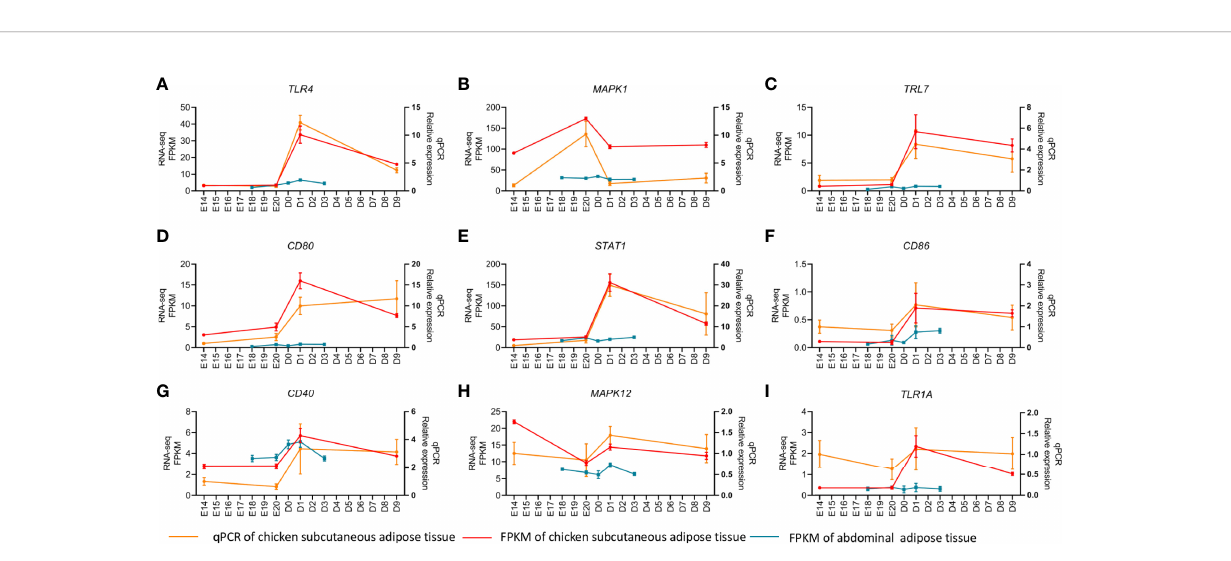
FIGURE 8 | qPCR veri fi cation of hub genes in chick subcutaneous and abdominal adipose tissues during the peri-hatching period in